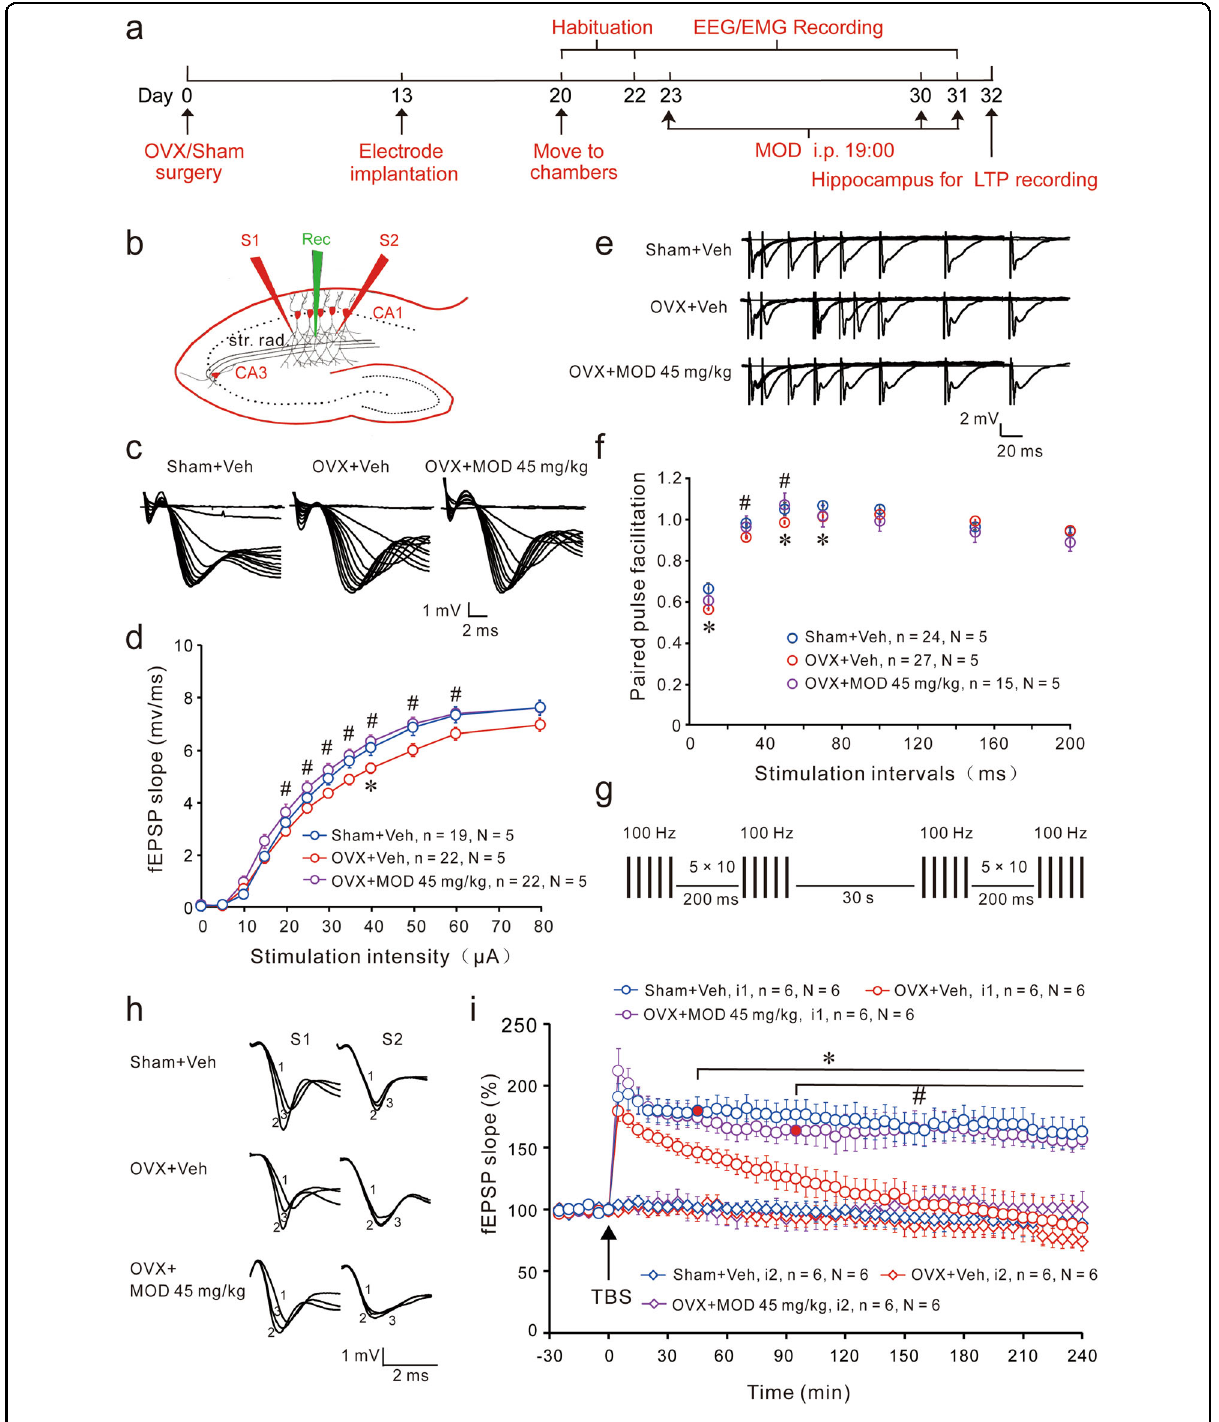
Fig. 3 (See legend on next